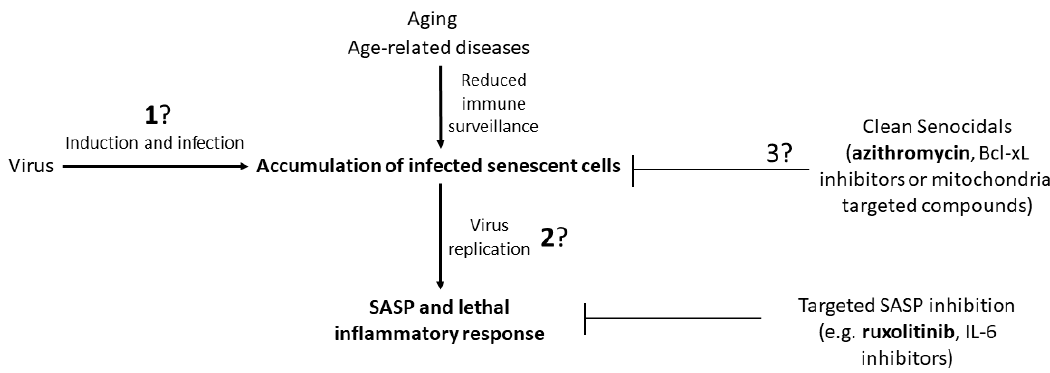
Figure 2. A schematic representation of the strategic therapies based on senotherapeutics that may be useful in the treatment of viral infections. Evidence from ongoing clinical trials point at azithromycin and ruxolitinib as major candidates in this field. Three aspects that need to be clarified by research before addressing the proper therapy are highlighted by question marks: (1) Information on the capacity of the virus to induce senescence and if the virus displays a preference to replicate in non-senescent versus senescent cells. (2) Understanding if viral replication is suppressed by cellular senescence or if the virus evolved mechanism(s) to bypass or use senescence to enhance replication. (3) In the case of strategies based on senocidals, it should be clarified if there are drugs or similar therapies that can induce cell death without favoring the spreading of the virus to neighboring cells. Selective Bcl-xL inhibitors and mitochondrial targeted compounds are likely candidates to induce a ‘clean’ apoptosis, avoiding the spreading of viral particles.